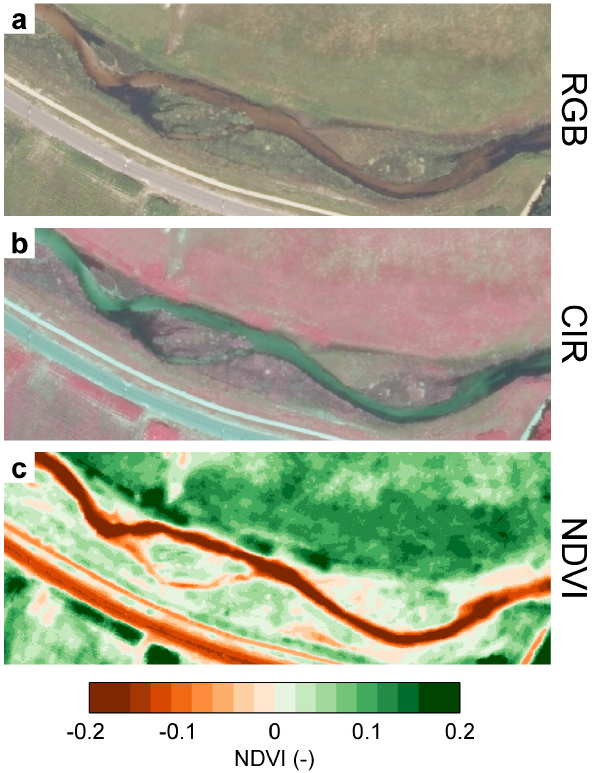
Figure 3. An example of the second aerial photograph (day 289) from which the NDVI was determined, showing (a) the RGB image (red, green, blue), (b) the CIR image (colourized infrared) and (c) the NDVI. In (c) , the green-coloured areas indicate positive NDVI values, and orange-coloured areas indicate negative NDVI values. All images have a 25cm